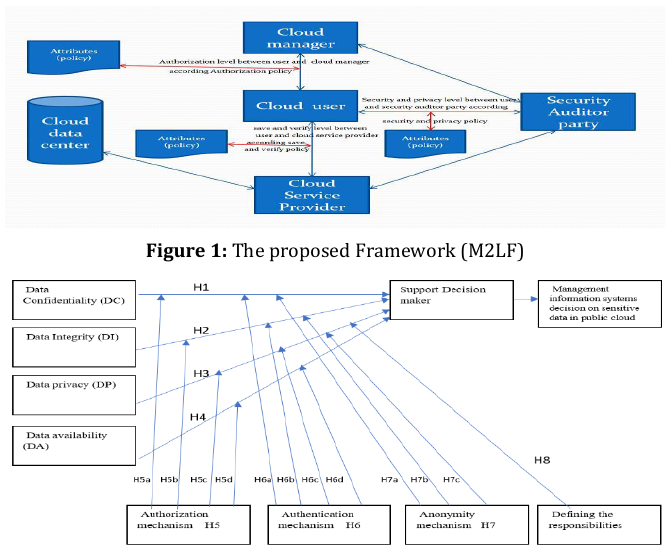
Figure 2: Hypotheses model to management information systems decision on sensitive data in cloud computing According to these factors, the study proposed a multi layered framework (M2LF) to enhance management information systems decision making on sensitive data in cloud computing environment as depicted in Figure 1. Figure 2 explains the hypotheses and factors which enhancing the management of information system decision